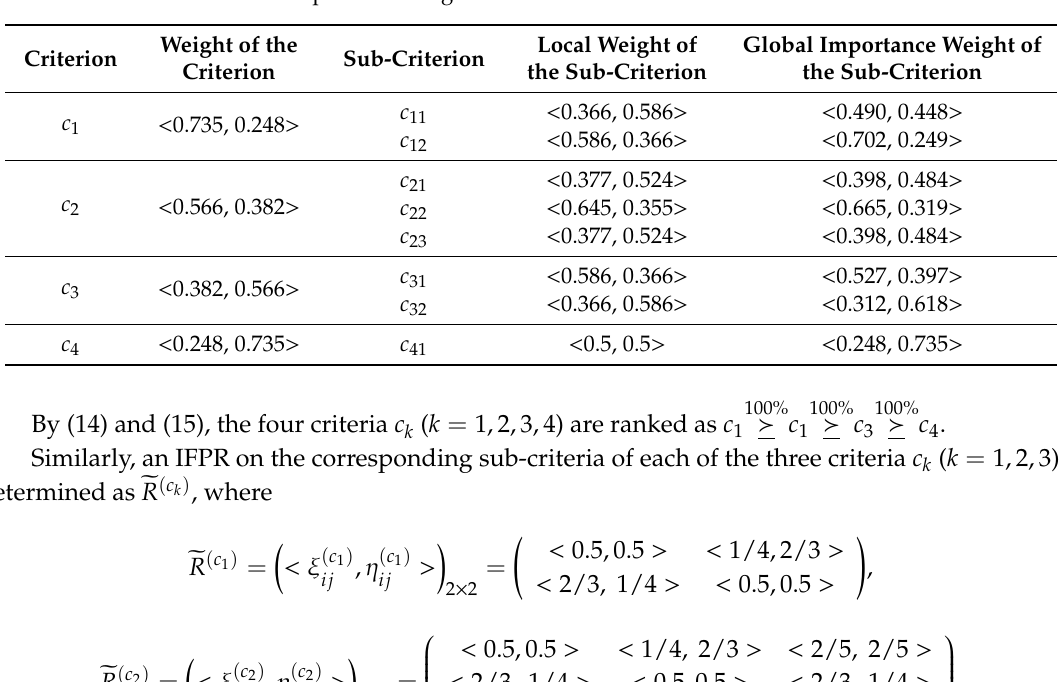
Table 4. Importance weights of evaluation criteria and